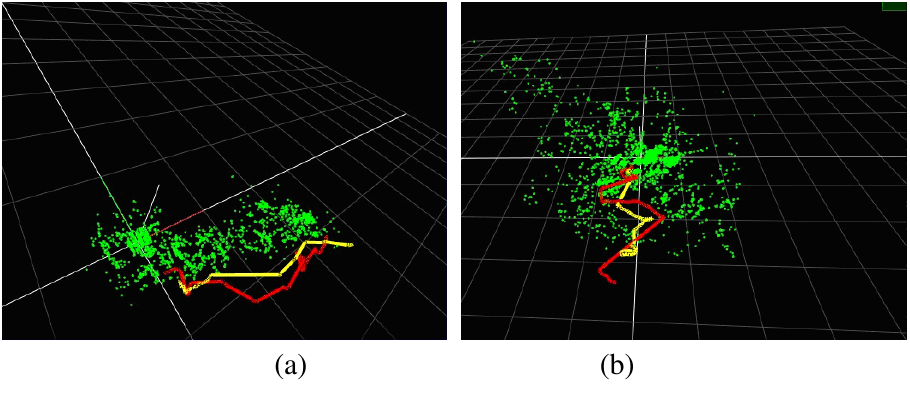
Figure 9. Maps and trajectories used to test the performance of the enhanced PROSAC algorithm.